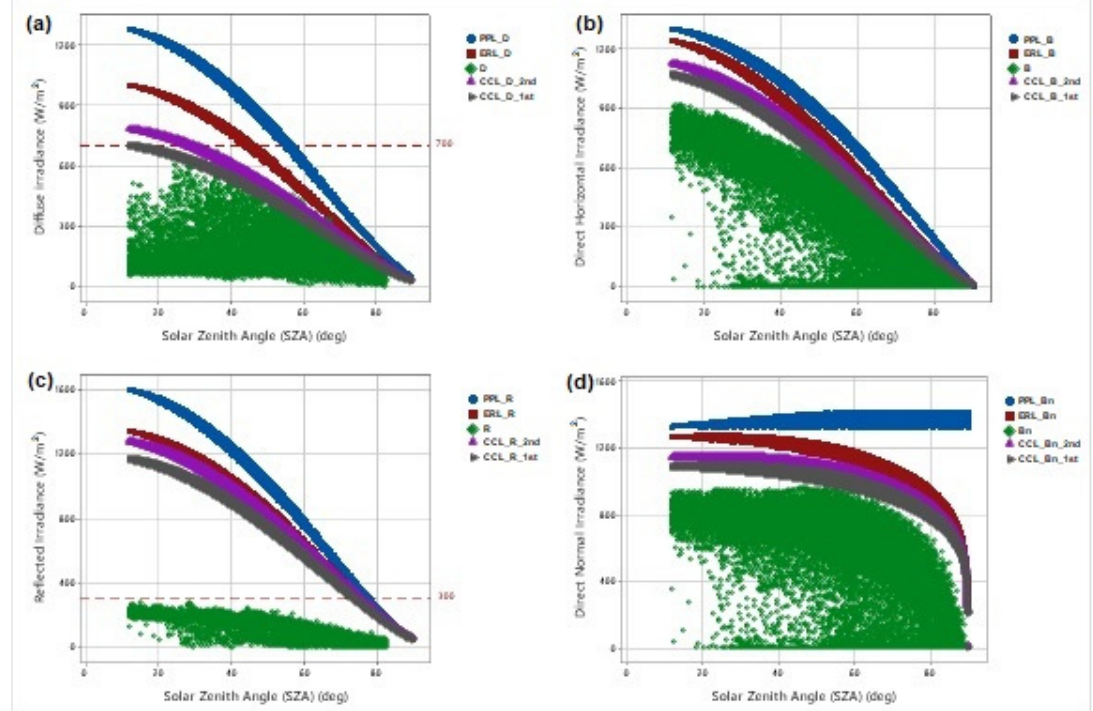
Figure 7. Graphical representation of PPL, ERL and CCL tests of the average 10 min irradiances of: ( a ) the diffuse on solar tracker ( D ); ( b ) direct horizontal ( B ); ( c ) reflected ( R ); and ( d ) direct normal irradiance as a function of solar zenith angle (SZA).